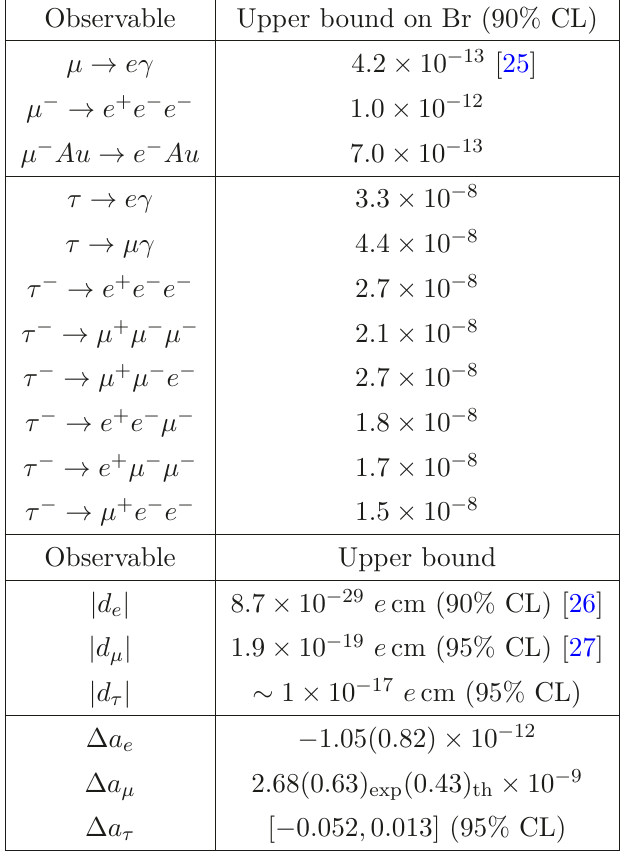
Table 2 . Current upper bounds on the most relevant lepton flavor-violating observables, as well as on the lepton electric and magnetic dipole moments. Bounds are all taken from the Particle Data Group [28], unless stated otherwise. We defined ∆ a = a exp emphasizes this quantity suffers from large experimental uncertainties (see [28] for precise